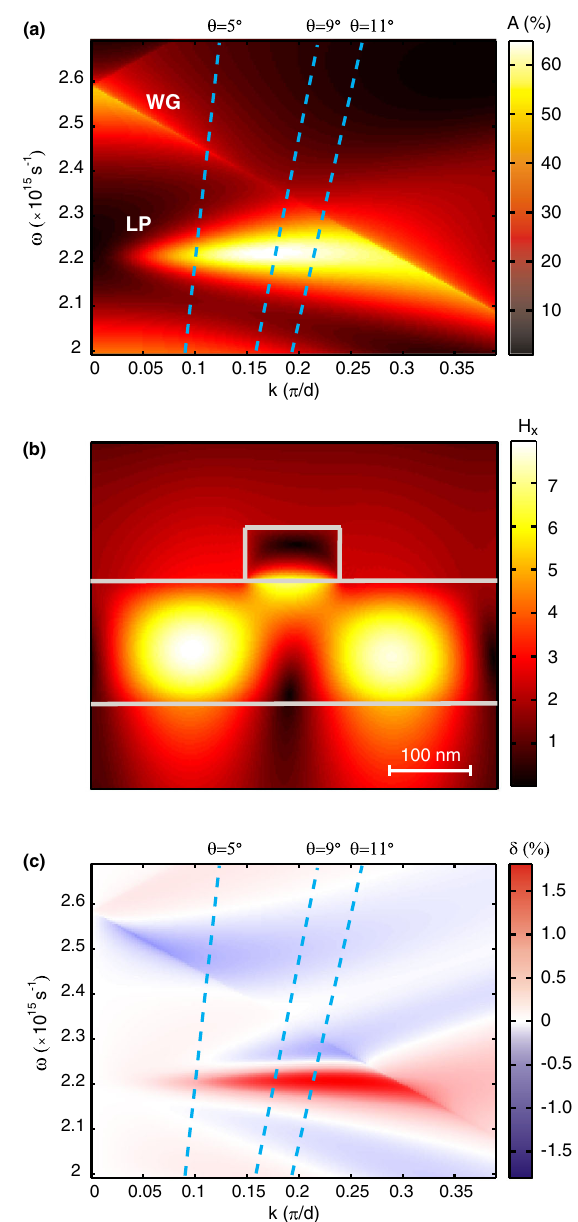
FIG. 4. (a) Simulated dispersion diagram of absorbance A for the sample with a 500-nm period for TM polarization. The blue lines indicate the ! (cid:1) k relations at 5 (cid:2) , 9 (cid:2) , and 11 (cid:2) incident angles, respectively. The high absorbance (bright area, denoted by LP) at around ! ¼ 2 : 2 (cid:4) 10 15 s (cid:1) 1 is due to the localized plasmon resonance. The dispersive feature in the diagram de- noted by WG is due to the waveguide mode. (b) Simulated (ampli- distribution of the oscillating magnetic field of light H x tude of the x component) along the gold nanowires for the structure of a 500-nm period at a 9 (cid:2) incident angle and a 860-nm wavelength ( ! ¼ 2 : 2 (cid:4) 10 15 s (cid:1) 1 ). The magnetic field is normalized to the amplitude of the incident light magnetic field. The waveguide and the gold nanowire are outlined by grey lines. (c) Simulated ! (cid:1) k diagram of the TMOKE signal (cid:1) for the structure of a 500-nm period. The external magnetic field is 160 mT, and illumination is TM